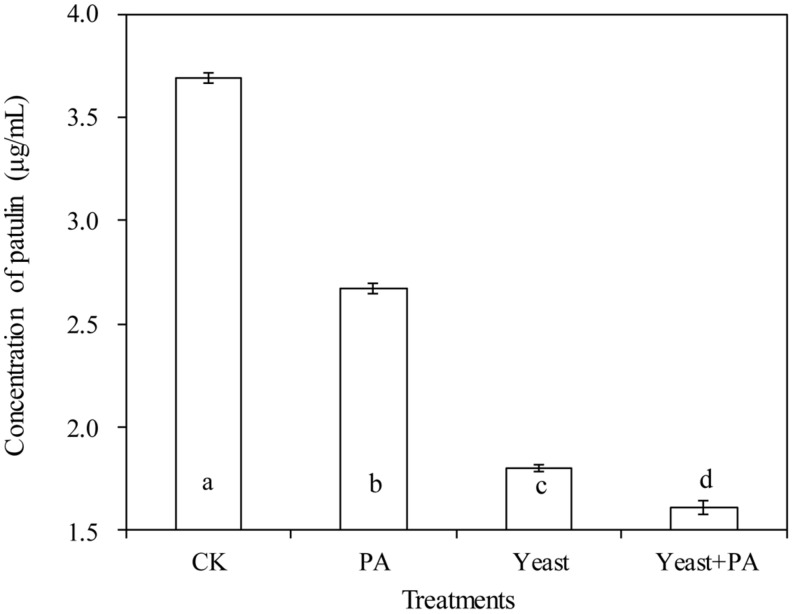
Effects of R. mucilaginosa in combination with PA on patulin content produced by P. expansum in NYDB media. Treatments are as follows: CK = sterile distilled water, PA = 4 μmol/mL PA, yeast = R. mucilaginosa (1 × 108 CFU/mL), yeast + PA = R. mucilaginosa (1 × 108 CFU/mL) + 4 μmol/mL PA. Each value is the mean of two experiments. Bars represent standard deviations. Different letters indicate significant differences (P < 0.05) according to the Duncan’s multiple range test.